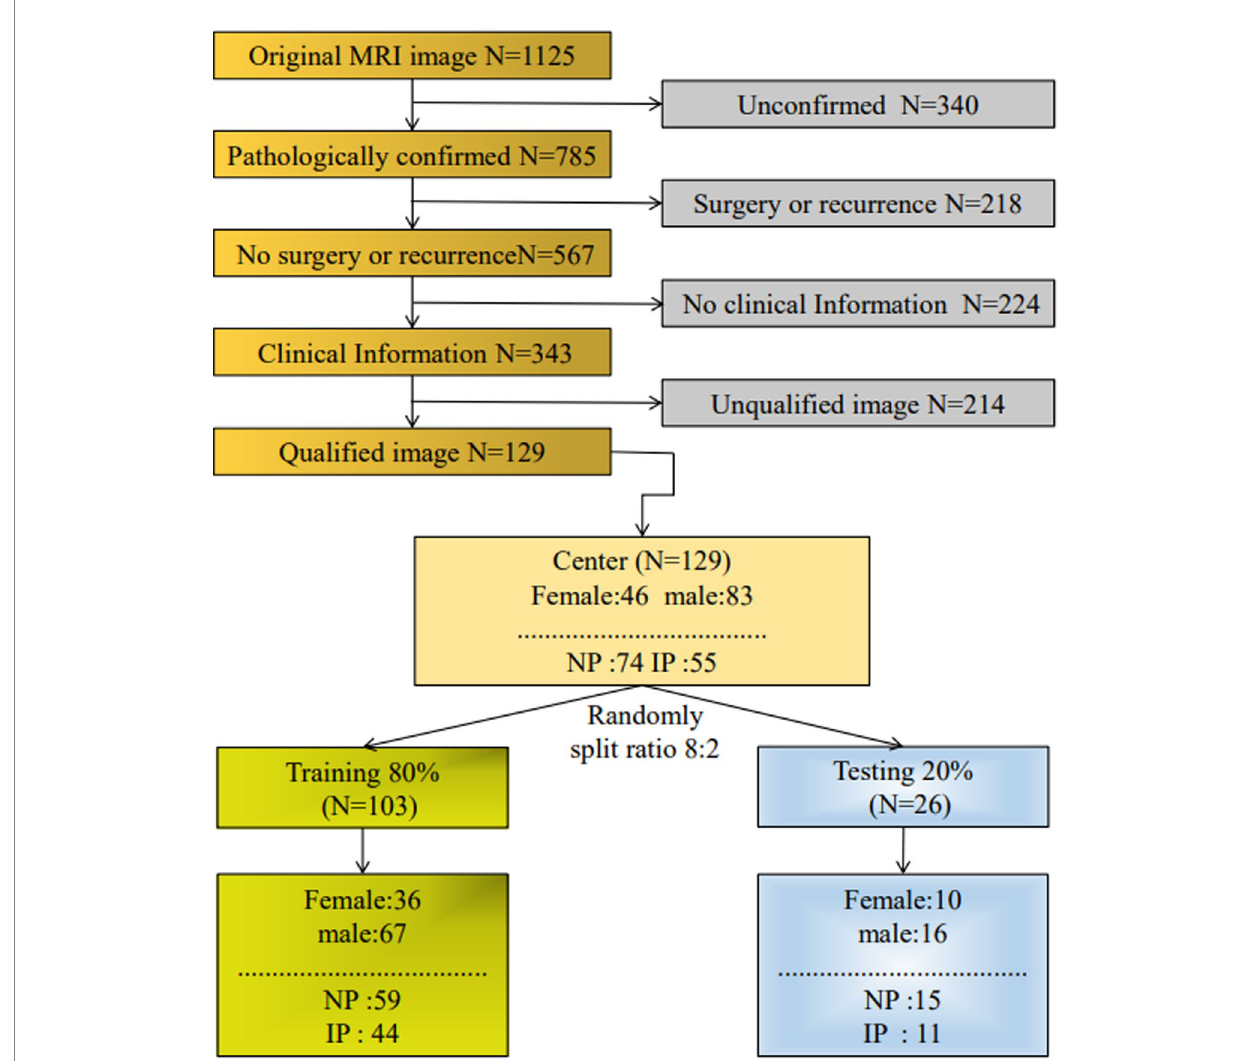
FIGURE 1 Filter flowchart. Through the inclusion and exclusion criteria of each step, a total of 129 patients were enrolled in the study and randomly assigned to training or testing